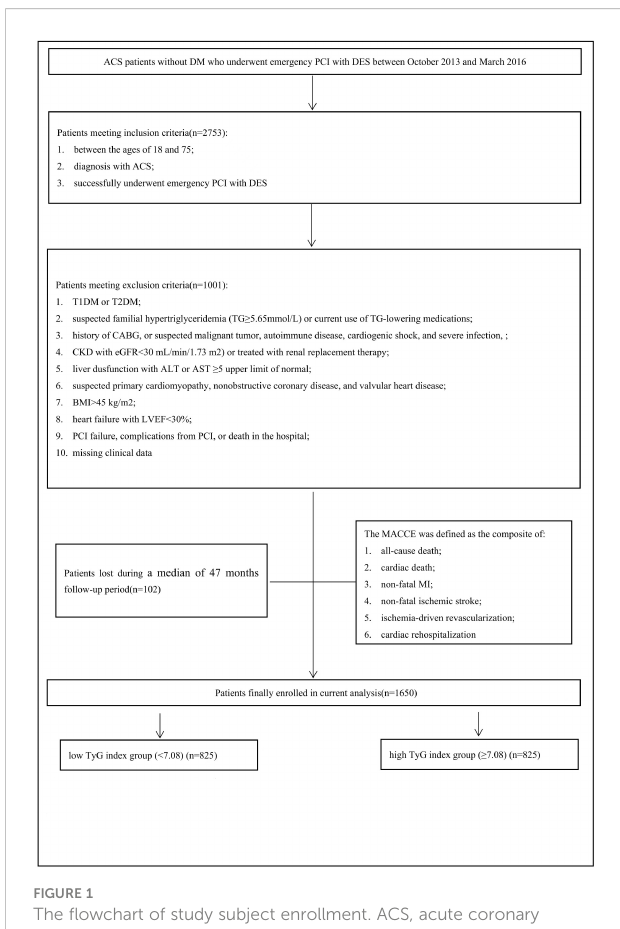
FIGURE 1 The fl owchart of study subject enrollment. ACS, acute coronary syndrome PCI, percutaneous coronary intervention. DES, drug-eluting stent; TG, triglyceride; TIDM, type I diabetes mellitus; CABG, coronary artery bypass grafting; CKD, chronic kidney disease; eGFR, estimated glomerular fi ltration rate; ALT, alanine transaminase; AST, aspartate transaminase; BMI, body mass index, LVEF, left ventricular ejection fraction; MACCE, major adverse cardiovascular and cerebrovascular events, MI, myocardial infarction; TYG,